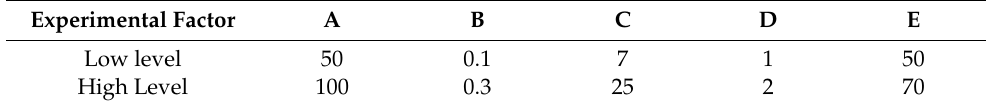
Table 1. Experimental factors and levels.